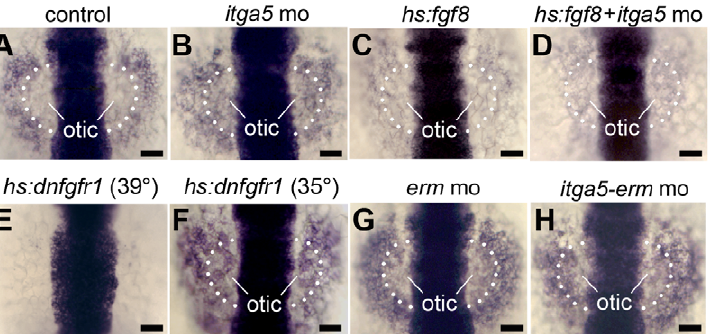
Figure 7. Similar effects of Itga5 and Fgf on sox3 expression. ( A–H ) sox3 expression at 12.5 hpf in a control embryo (A), itga5 morphant (B), Tg(hs:fgf8/ + ) heat shocked at 37 u C alone (C) or with itga5 morpholino (D), Tg(hs:dnfgfr1/ + ) heat shocked at 39 u C (E) or 35 u C (F), erm morphant (G) and itga5-erm double morphant (H). The otic region where sox3 normally downregulates is indicated. Scale bar, 50 m m.